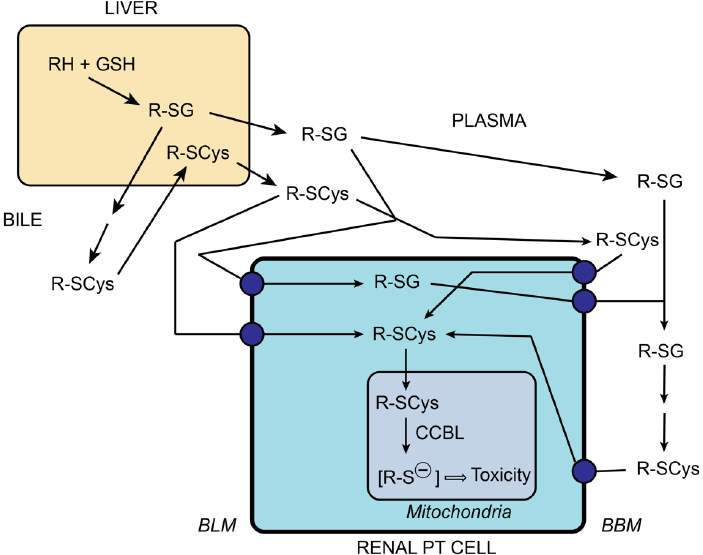
Figure 8. Interorgan metabolism of nephrotoxic GSH and cysteine S -conjugates. The scheme em- phasizes the roles of initial GSH conjugation, which primarily occurs in the liver, and interorgan transport pathways that deliver either the GSH S -conjugate or the cysteine S -conjugate to the kidneys, which rapidly transport these conjugates into the PT cell, where the cysteine S -conjugate can be bioactivated by the cysteine conjugate beta-lyase (CCBL) within mitochondria to produce a reactive thiolate or related metabolites (e.g., [R-S – ]) that cause